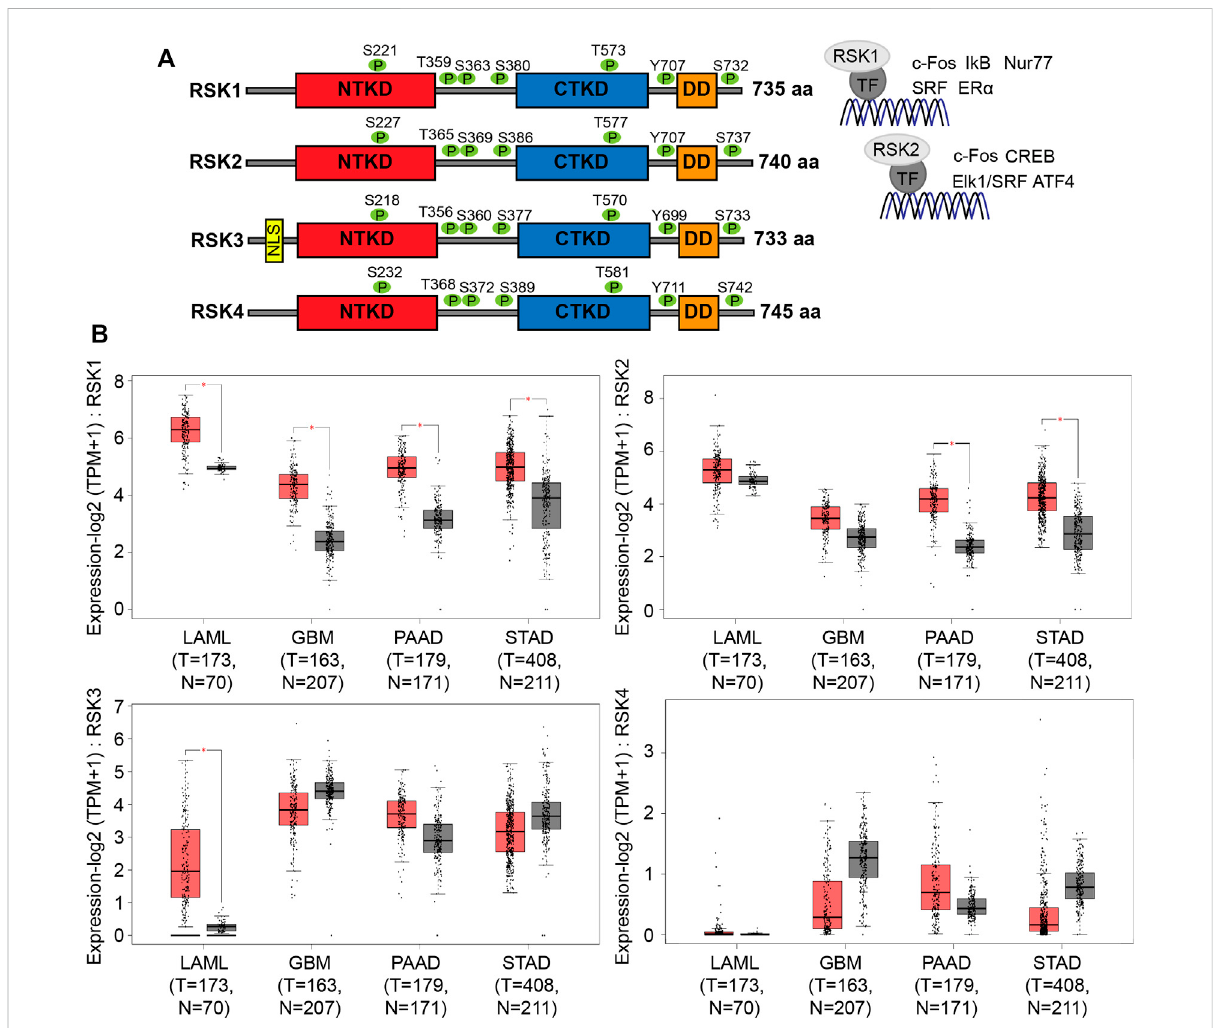
FIGURE 1 Structural andmRNA expression pro fi lesof RSKisoforms inmultipletumors. (A) Schematic representation shows thefunctional domains ofthe N-terminal kinase domain (NTKD), C-terminal kinase domain (CTKD), and docking domain (DD). Activation of RSK is associated with highly conservedphosphorylation sites(each shownasgreen coloredcircles).Transcription factorsregulatedbyRSK1andRSK2 areshownontheright. (B) Box plots show tumor (red) and normal samples (gray) that revealed upregulation of RSK1 and RSK2 in acute myeloid leukemia (LAML), glioblastoma multiforme (GBM), pancreatic adenocarcinoma (PAAD), and stomach adenocarcinoma (STAD). The height of each bar represents the median expression of certain tumor or normal tissues (T = Tumor, N=Normal). Data were analyzed using the gene expression pro fi ling interactive analysis 2 (GEPIA2) database. *, p <